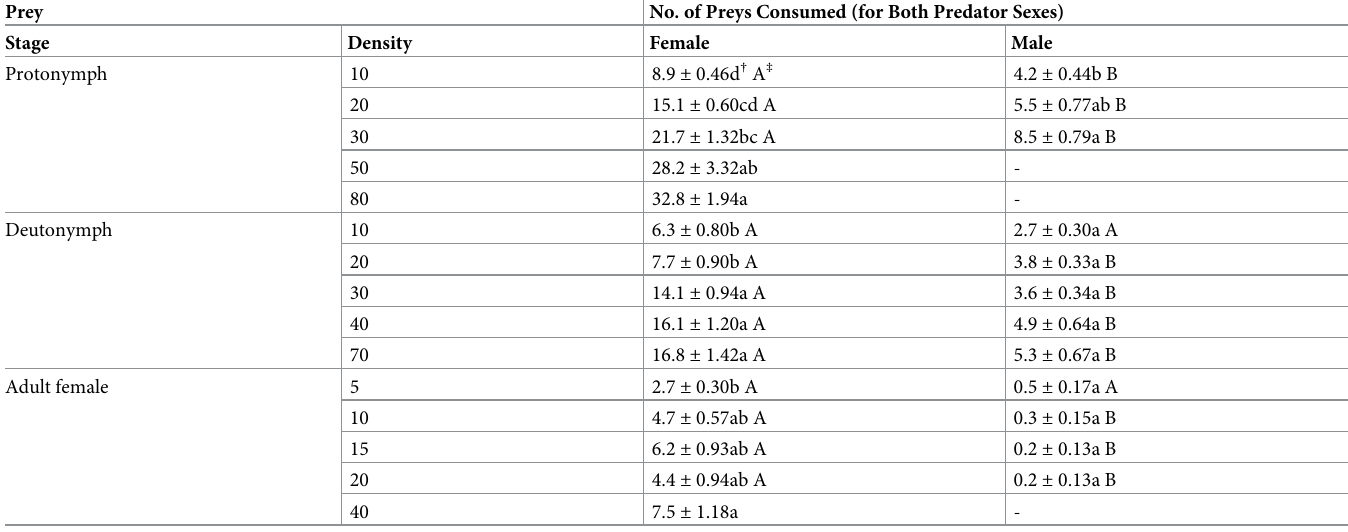
Table 4. Predation rate (as number of preys consumed, mean ± SE) of Amblyseius eharai on Tetranychus urticae in the protonymph, deutonymph, and female adult life stages. Prey No. of Preys Consumed (for Both Predator Sexes) Stage